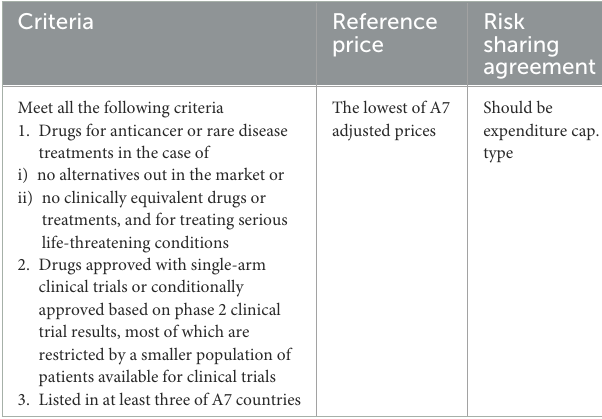
TABLE 4 Criteria for cost-effectiveness analysis exemption in South Korea (52,